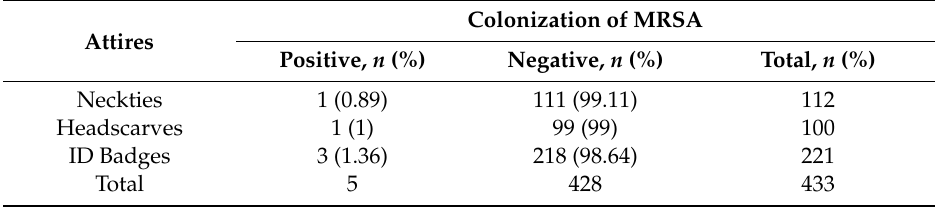
Table 5. Colonization of MRSA on neckties, headscarves, and ID badges among medical